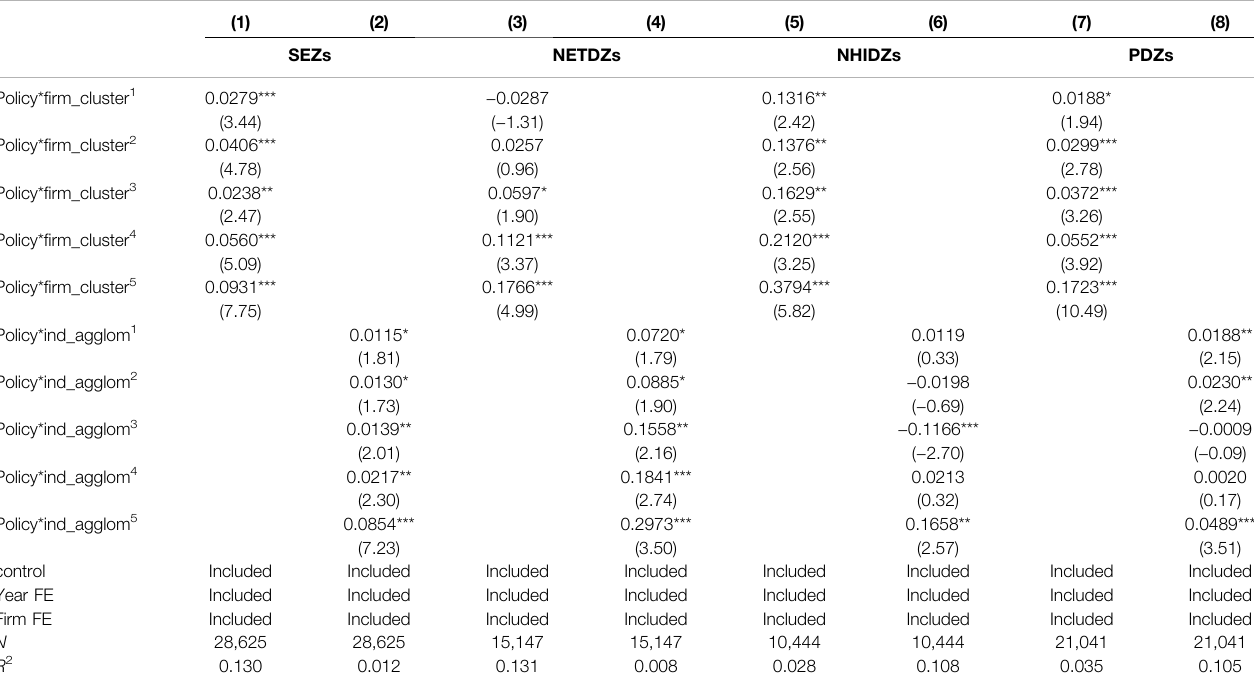
TABLE 7 | The lagging effect of agglomeration effect in promoting enterprise green technology